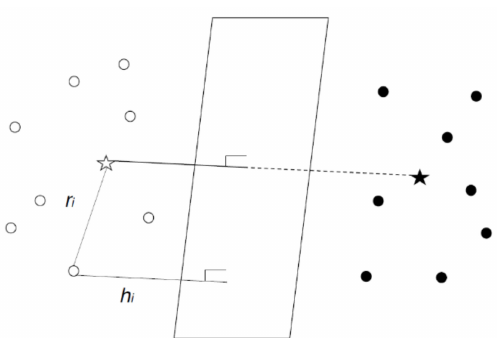
Figure 3. Distances r from the center and h from the virtual hyperplane are shown. The two-star shapes are the centroid of each